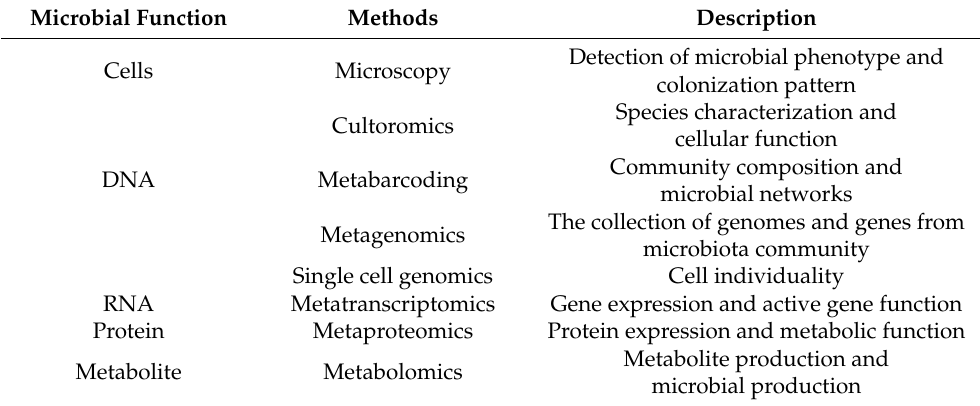
Table 1. Development of methods for microbiome research